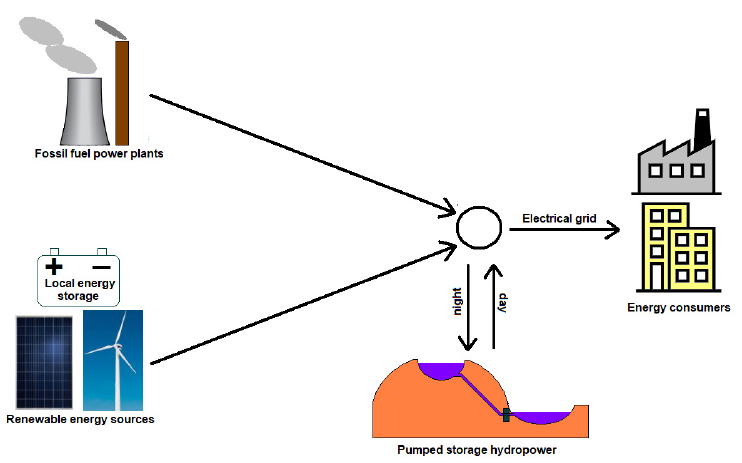
Figure 1. Structure of the actual electrical energy market in Poland. Currently operating energy storage facilities only allow for the daily balancing of the electricity market, own elaboration.